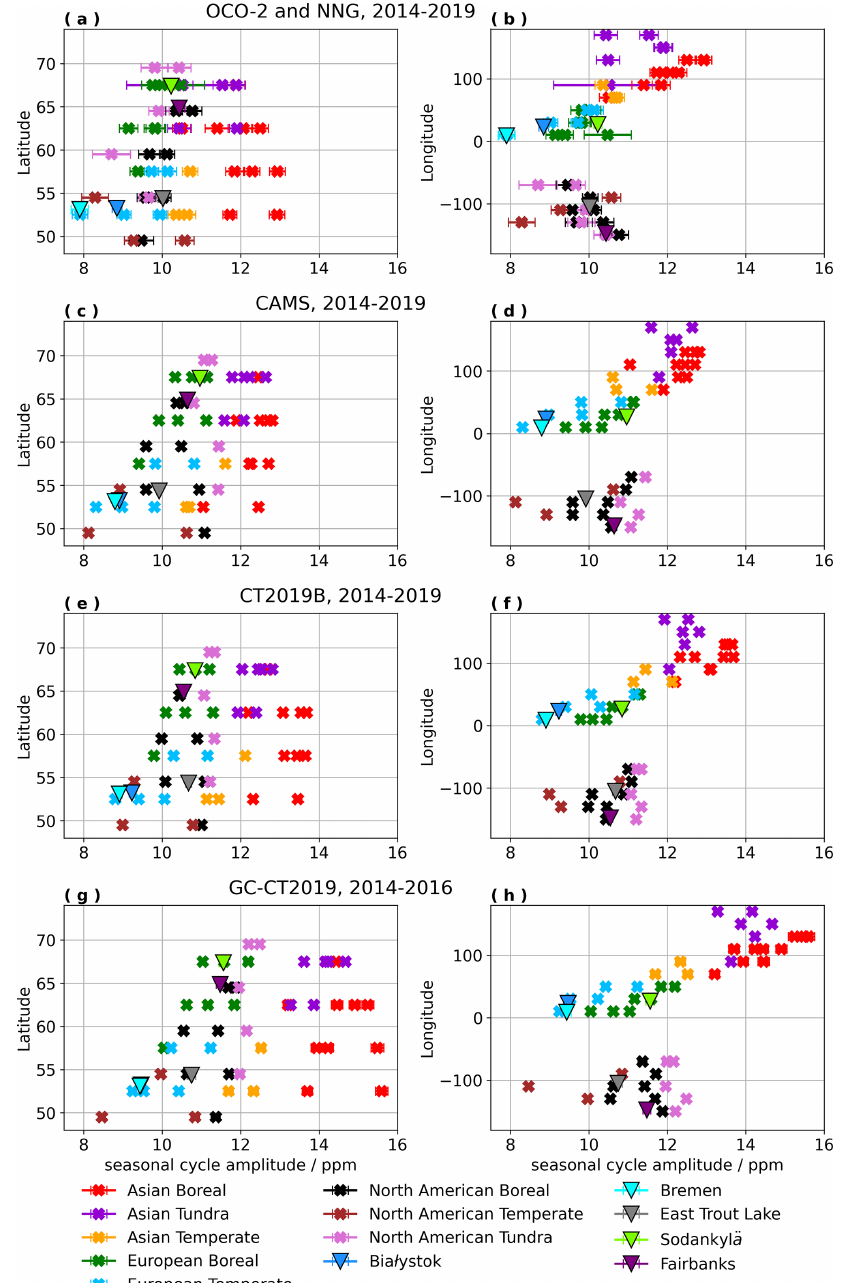
Figure 6. Plots of latitude and longitude correlated to SCA using observational results from OCO-2 and NNG observations (a, b) , CAMS model estimates (c, d) , CT2019B model estimates (e, f) , and GC-CT2019 model estimates (g, h) . The latitude and longitude for each zone is located at its